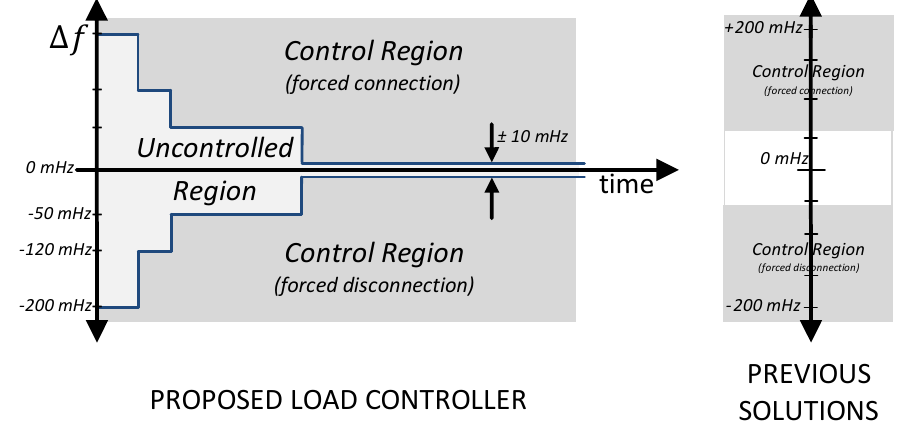
Figure 1. Individual load controller ∆ f -time